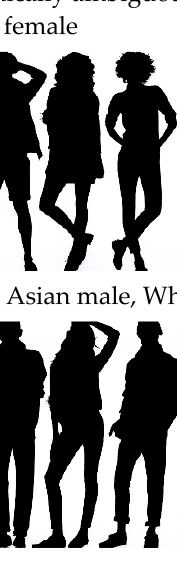
Figure 1. Simulated picture: monoracial ad and mixed ad.